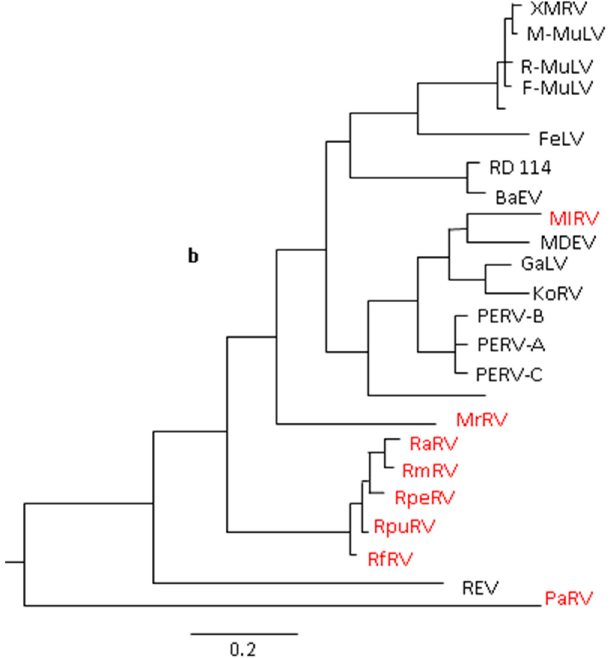
Figure 1. Phylogenetic trees of gibbon ape leukaemia virus (GaLV)- and koala retrovirus (KoRV)-related viruses. ( a ) GaLVs maximum likelihood phylogenetic tree using full genome sequences, modified after Alfano et al. [13]. GaLV-SEATO (GaLV from the Southeast Asia Treaty Organization Medical Research Laboratory in Bangkok), GaLV-Br (GaLV-Brain), GaLV-H (Hall’s Island), GaLV-X (GaLV from a human immunodeficiency virus type 1 (HIV-1) infected cell line), GaLV-SF (GaLV SanFrancisco) , Melomys woolly monkey virus (MelWMV) woolly monkey virus (WMV), Melomys burtoni retrovirus (MbRV); ( b ) maximum likelihood phylogenetic tree of the polymerase gene (amino acids) of GaLV-related gammaretroviruses modified after Cui et al. [14]. Xenotropic murine leukaemia virus (MuLV)-related virus (XMRV), prexenotropic MuLV-related virus 1 and 2; Moloney-, Rauscher- and Friend murine leukaemia virus (MuLV; M-, R-, F-MuLV); feline leukaemia virus (FeLV); feline RD114 virus (RD114); baboon endogenous retrovirus (BaEV); Megaderma lyra retrovirus (MIRV); Myotis ricketti retrovirus (MrRV); retroviruses from Rousettus affinis , R. pearsoni , R. megaphyllus , R. pussillu , R. ferrumequinum (RaRV, RmRV, RpeRV, RpuRV); reticuloendotheliosis virus (REV); Pteropus alecto virus (PaRV). Viruses marked red indicate bat gammaretroviruses.